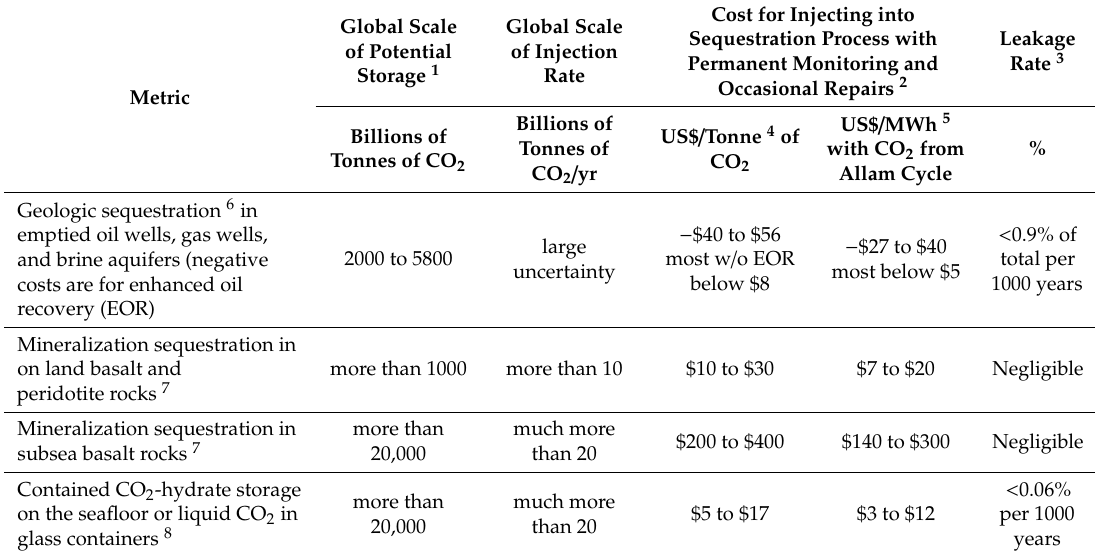
Table 4. Liquid or supercritical CO 2 sequestration scale and cost (from